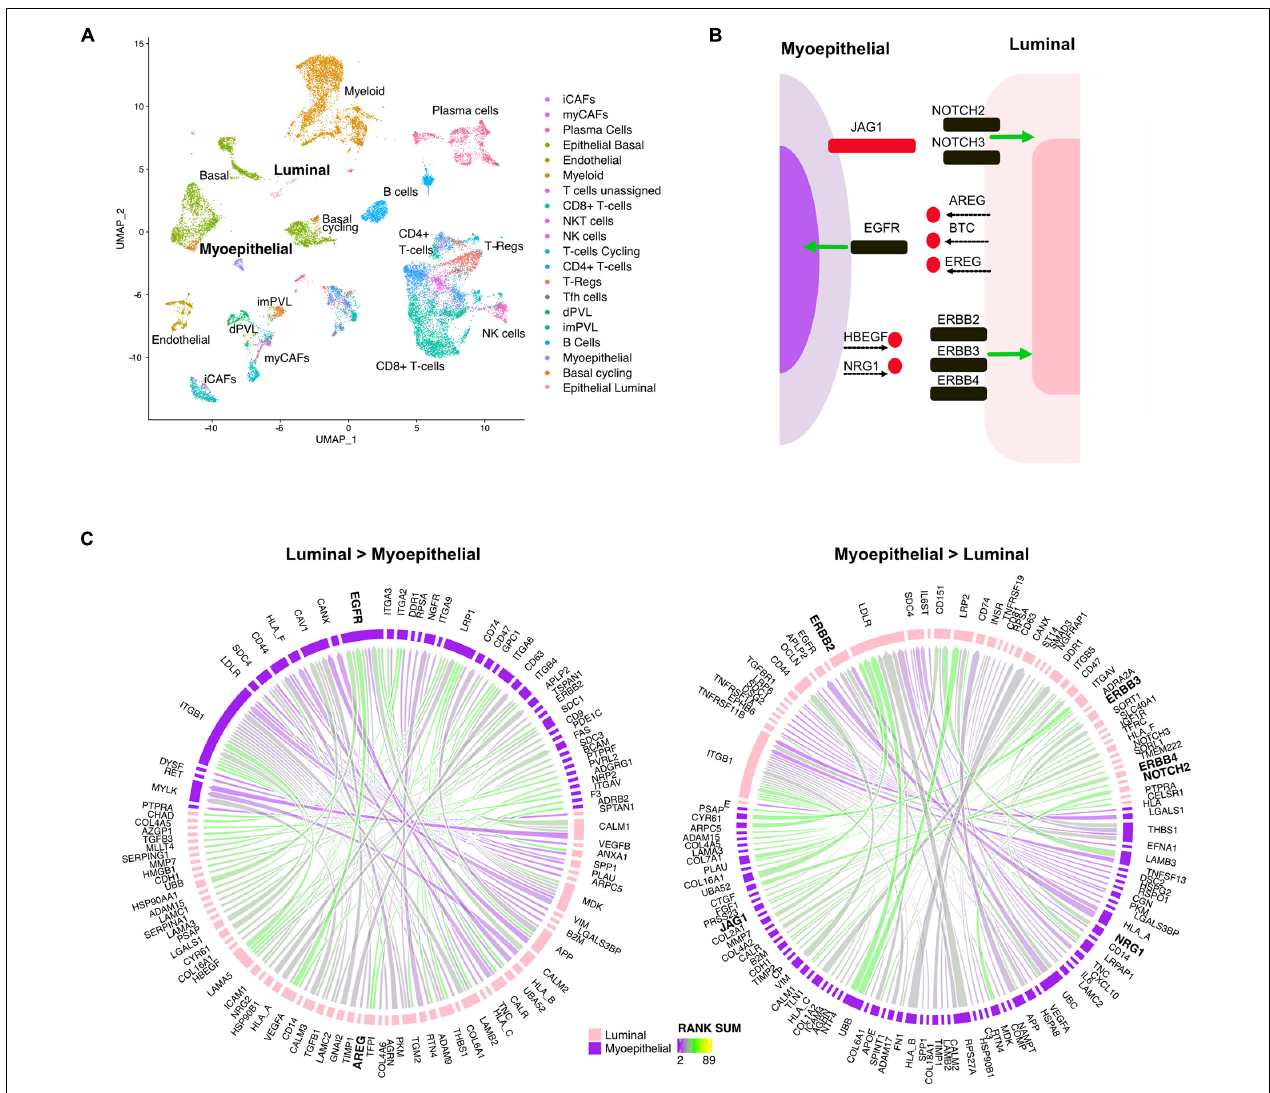
FIGURE 3 | Multiple ligand receptor interactions between luminal epithelial cells and myoepithelial cells. (A) UMAP plot shows distinct cell populations in five TNBC tumors. (B) Image shows unique ligand (red) receptor (black) interactions between myoepithelial and luminal breast cells. (C) Circos plots show the top interactions and by direction between myoepithelial and luminal cells. LR interactions are colored by interaction strength (rank sum) and line thickness represents the frequency of interaction across the five